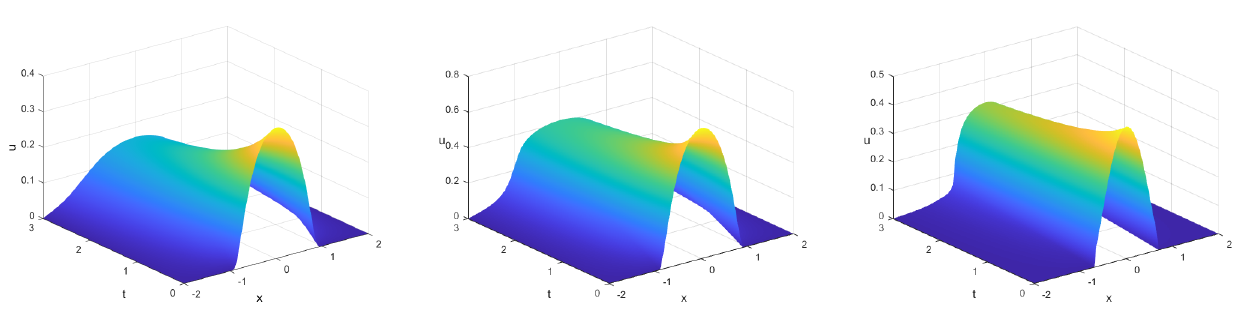
Figure 2. Solutions given by the method for m = 1 ( left ) m = 3 ( centre ) and m = 5 ( right ) using the first cloud of Figure 1.